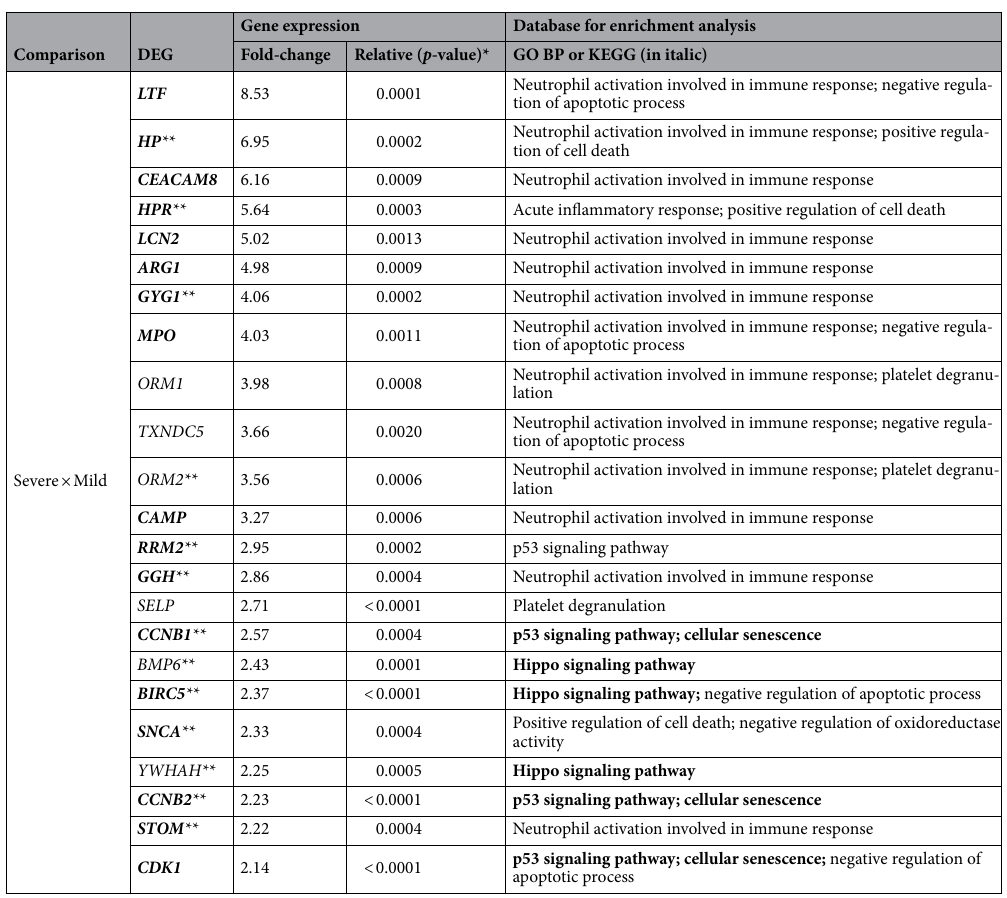
Table 2. DEGs selected as potential biomarkers for the Severe group and for the subgroup C. Genes in bold are hyper-expressed in the PBMC from COVID-19 patients (COVID-19 Related Gene Sets/Enrichr database). *t-test for relative expression of the DEGs normalized with endogenous reference gene GUSB . **Newly identified as a potential COVID-19 transcriptional